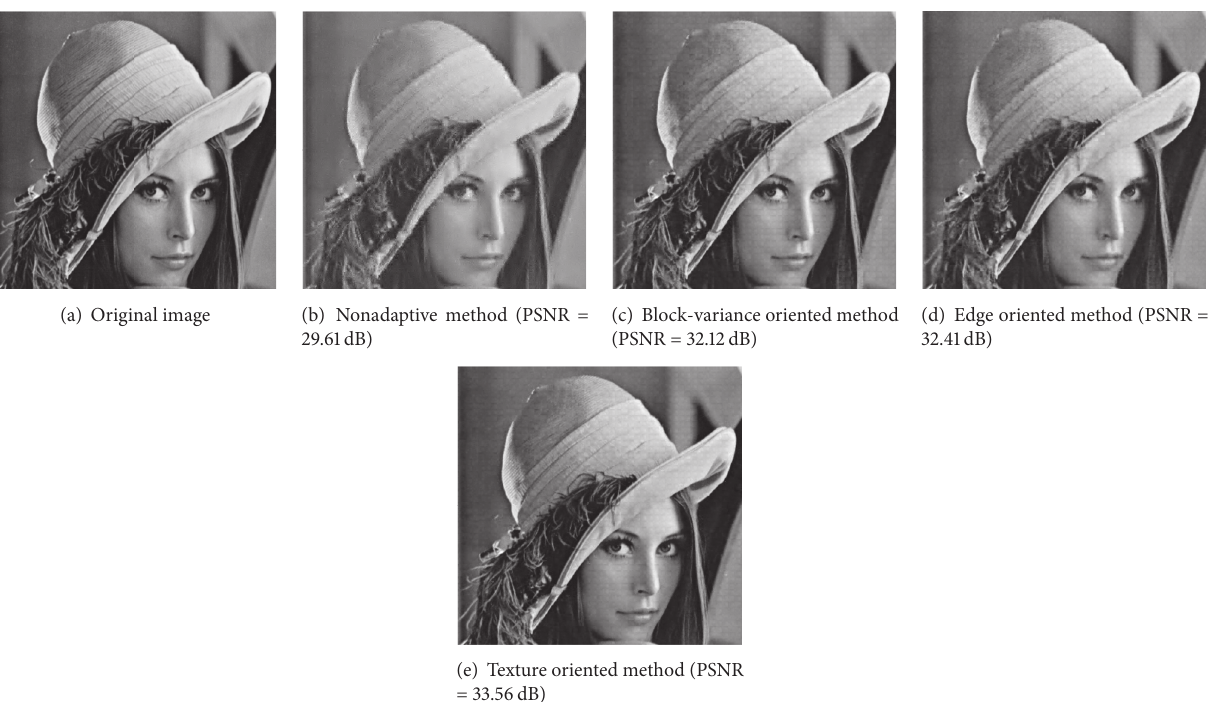
Figure 5: Comparison of visual qualities of 512 × 512 Lenna sampled by different methods when the sampling rate 𝑆 is 0.3.